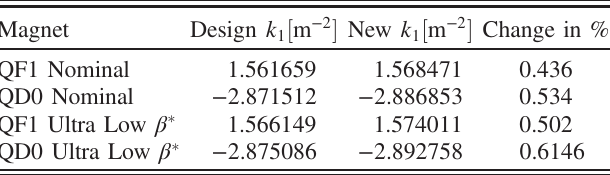
TABLE III. Change of the ATF2 FD magnets strength needed to correct the linear effect of the fringe fields. Magnet